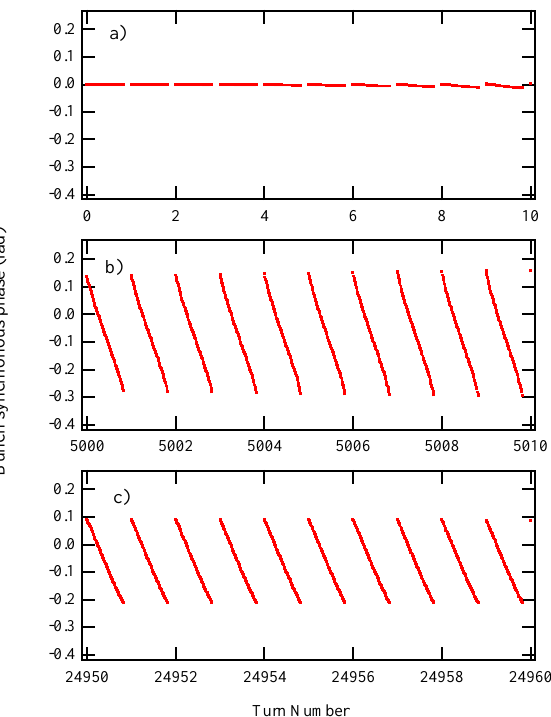
FIG. 5. (Color) Expanded view of tracking results from Fig. 4b. The relative synchronous phase of each bunch in the train evolves to a transient variation of about 0.3 rad. This shows good agreement with experimental observations.